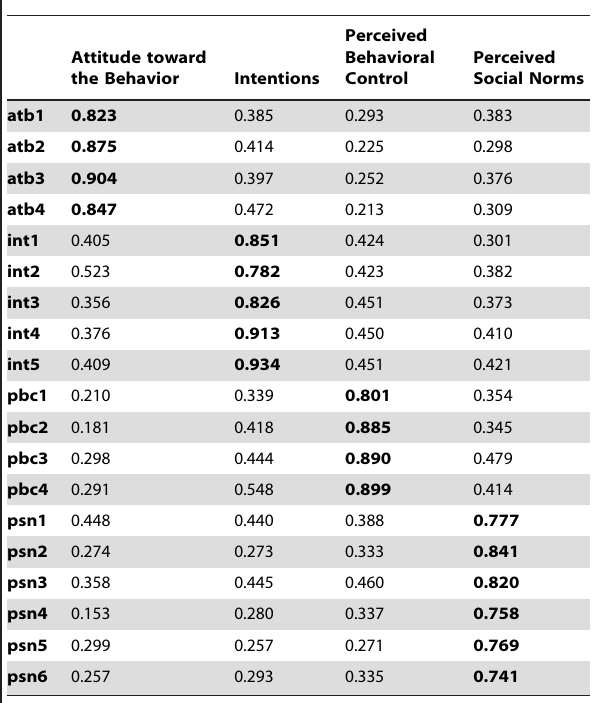
Table 3. Outer model loadings and cross loadings.